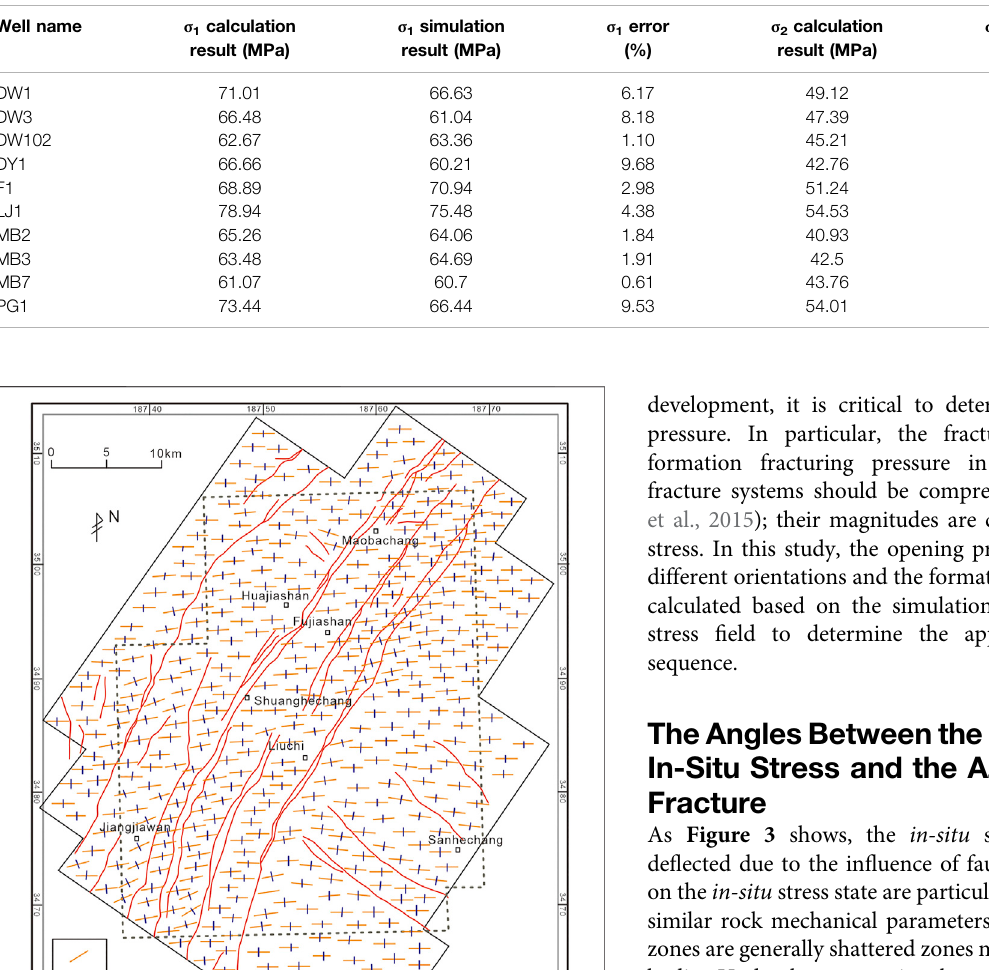
Frontiers in Earth Science |